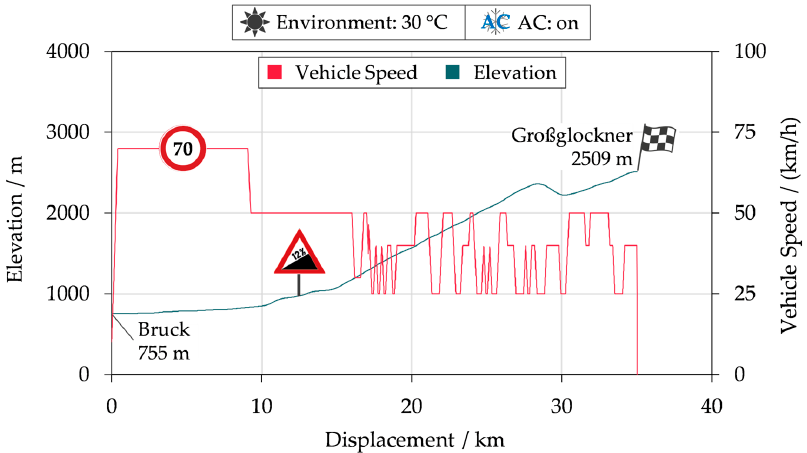
Figure 13. Großglockner real world driving scenario with corresponding vehicle speed and elevation profile.